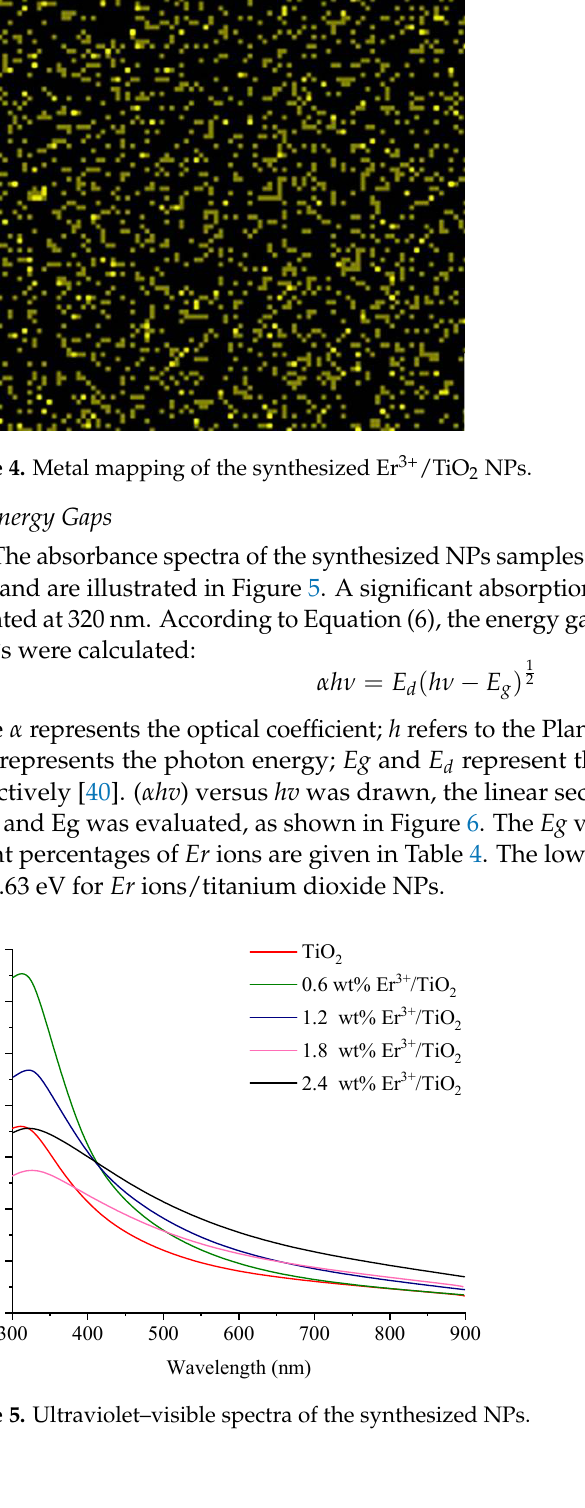
Figure 5. Ultraviolet–visible spectra of the synthesized NPs.